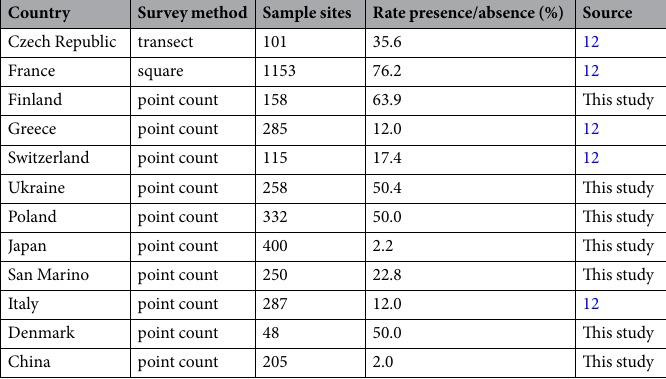
Table 3. Summary of survey methodology, number of sample sites, rate of occurrence of common cuckoo and source of data (published or unpublished) for 12 countries where observations of common cuckoos were